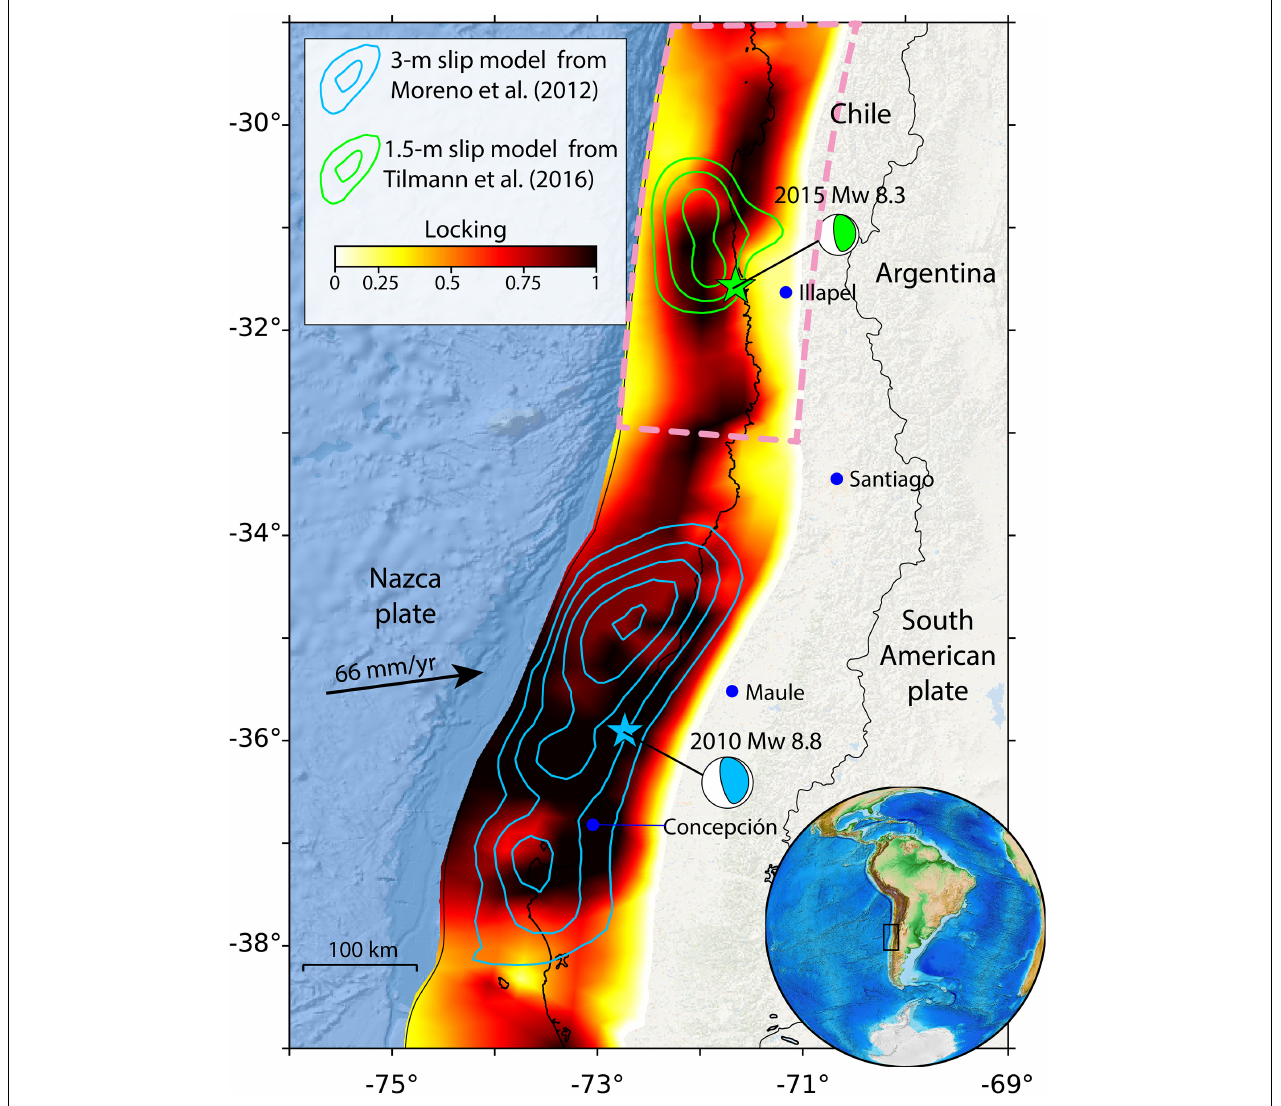
FIGURE 1 | Study area with slip models for the Maule (Moreno et al., 2012) and Illapel (Tilmann et al., 2016) earthquakes, interseismic locking prior to the 2010 Maule events from Tilmann et al. (2016) and main cities are also shown in blue circles. Dashed-pink polygon represents the area of the receiver fault (projected on surface) used to calculate the CFS changes in Figures 3 , 4